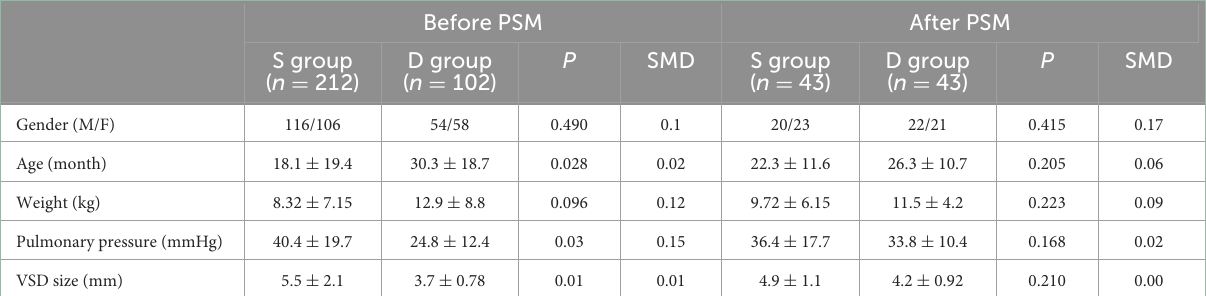
TABLE 1 Comparison of basic data between surgery repair group (S group) and transthoracic device closure group (D group). Before PSM